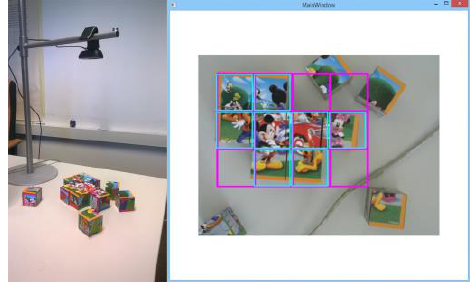
Figure 3. Overview of the gaming station and the visual